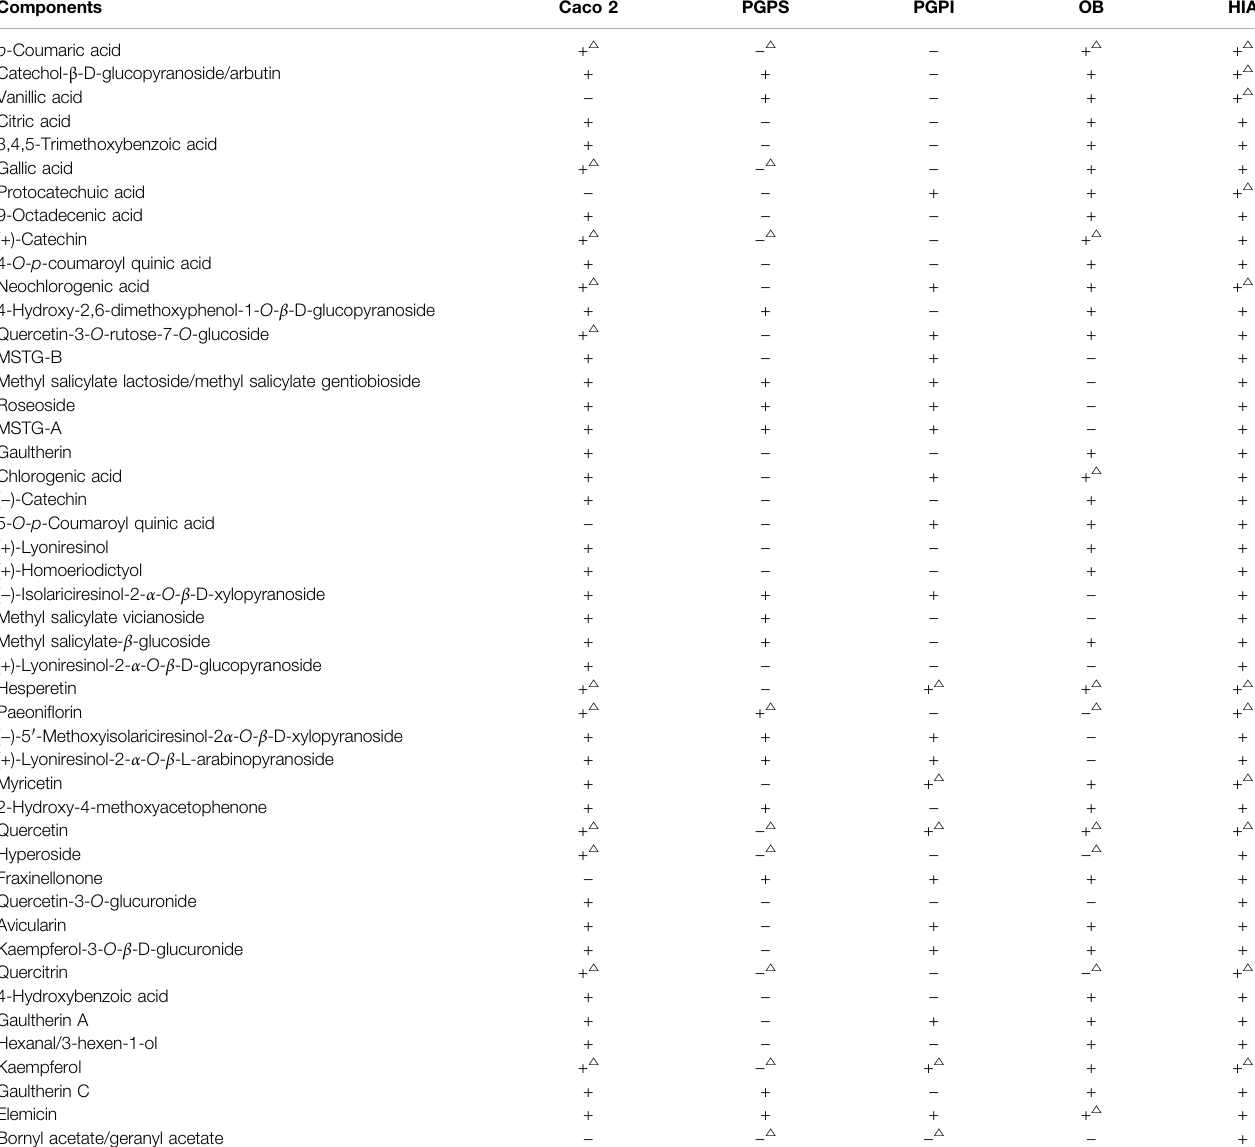
TABLE 1 | ADME properties prediction results of the compounds in ARF. Components